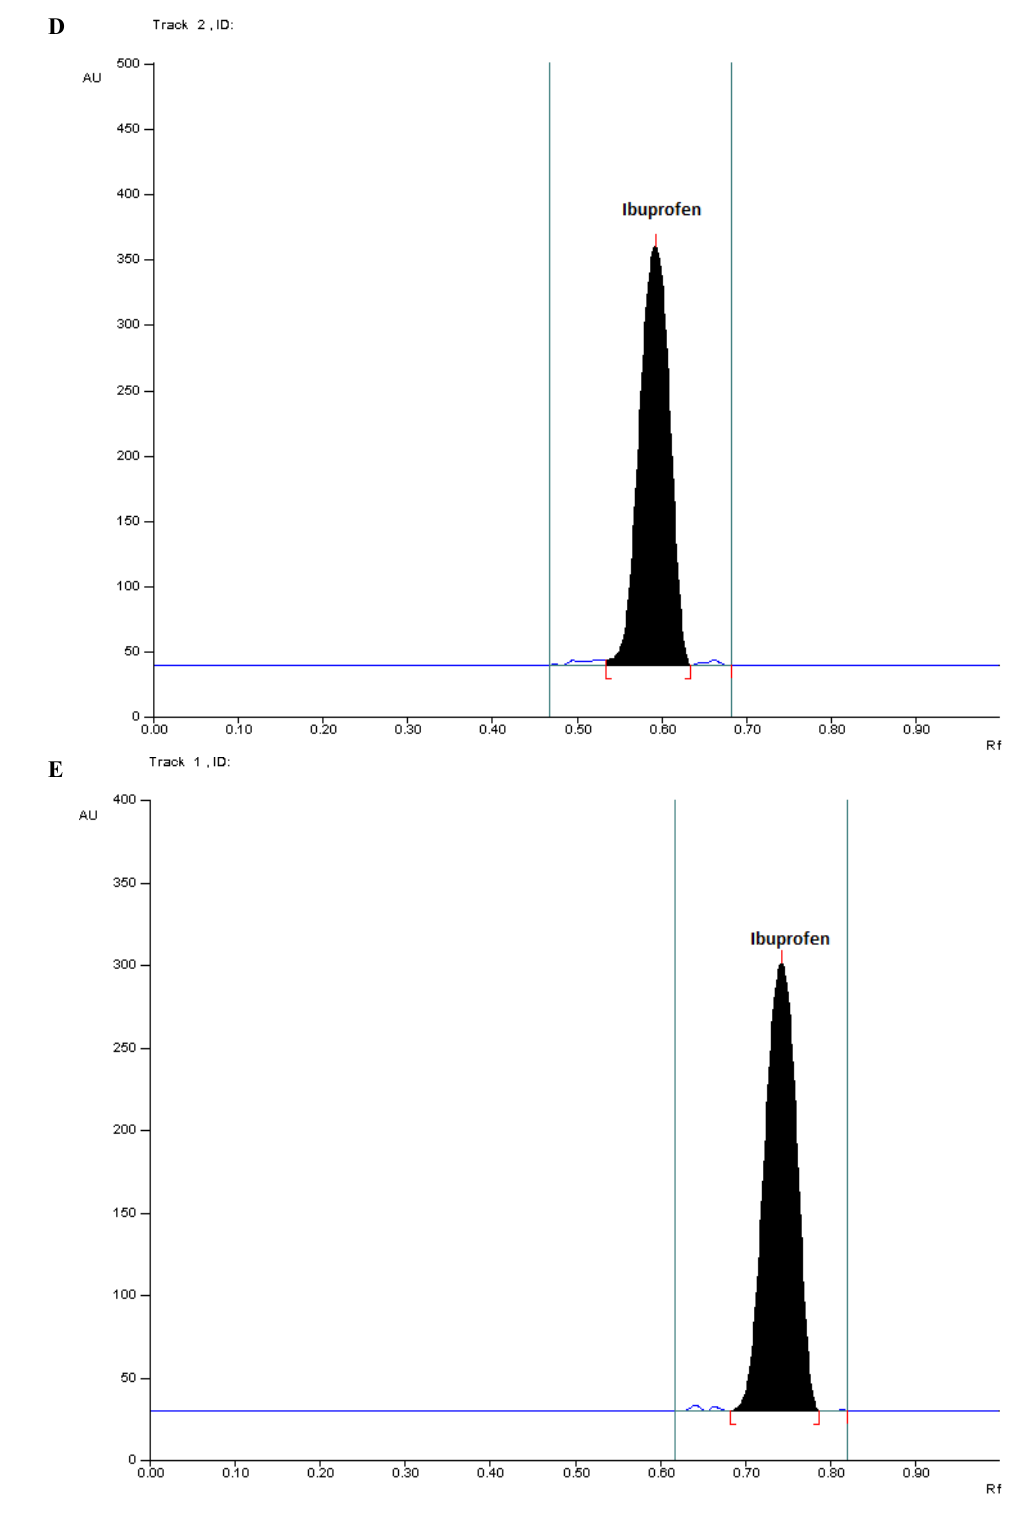
Figure 3. Exemplary chromatograms of ibuprofen registered on chromatographic plates 1.05554 developed with mobile phase toluene:ethyl acetate:glacial acetic acid (27:21:2, v/v/v) ( A ) and using mixture n -hexane:ethyl acetate:glacial acetic acid (36:12:2, v/v/v) ( B ) as well as on RP-18F 254 plates examined by means of methanol:water (40:10, v/v) ( C ), ethanol:water (40:10, v/v) ( D ), and propan-1-ol:water (40:10, v/v) ( E ).